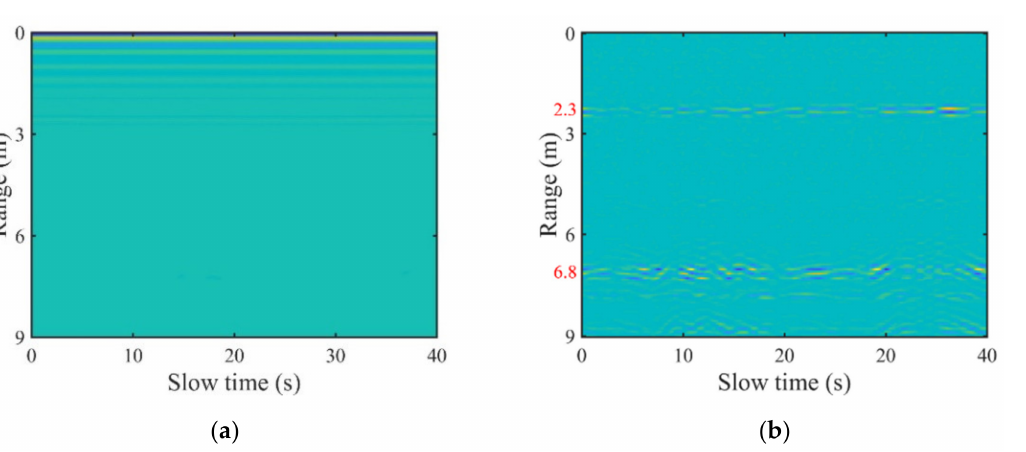
Figure 7. Raw and preprocessed radar data when a human stands stationary at approximately 2.5 m from the UWB radar and when the digging wheel loader is approximately at 6 m. ( a ) Raw data, and ( b ) preprocessed